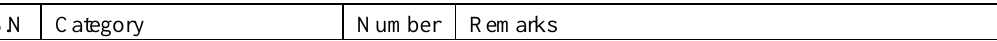
Table 3: Classification of the indicators: